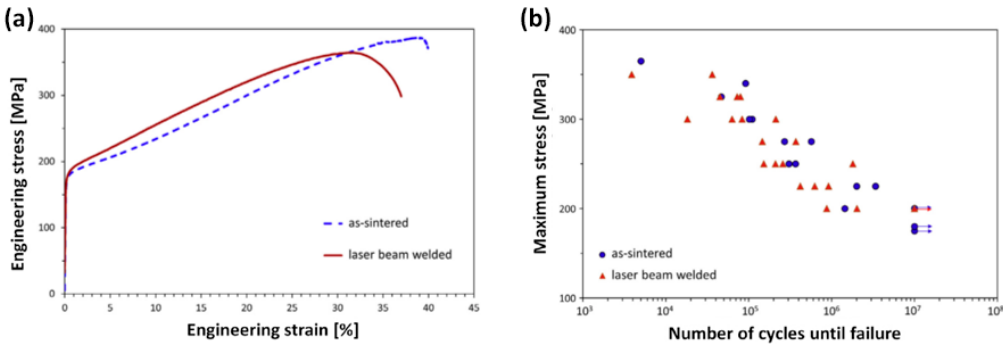
Figure 3. Laser beam welds characterization: ( a ) Tensile testing; ( b ) fatigue testing (Adapted from [54], with permission from Elsevier, 2019).